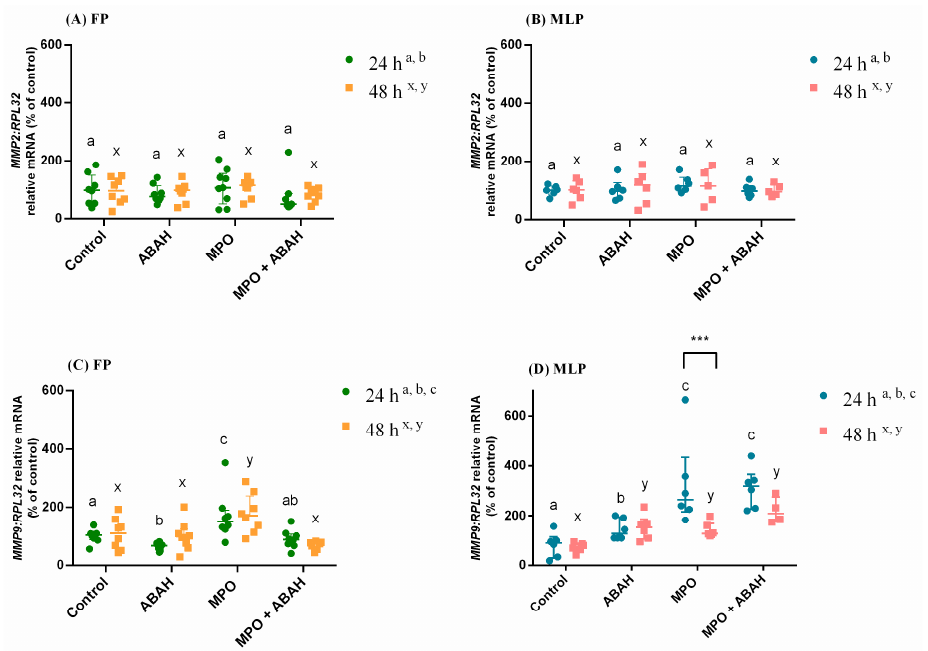
Figure 2. Transcription of MMP2 ( A , B ) and MMP9 ( C , D ) relative mRNA in mare endometrial explants from the follicular phase (FP) and the mid-luteal phase (MLP) treated with culture medium only (Control), myeloperoxidase (MPO: 0.5 µ g/mL), 4-aminobenzoic hydrazide (ABAH: 10 µ g/mL), or MPO (0.5 µ g/mL) + ABAH (10 µ g/mL) for 24 or 48 h. Results are presented as median with interquartile range. Significance was determined at p < 0.05. The differences among treatments with the same treatment time are signaled by distinct superscript letters (a,b,c—24 h; x,y—48 h). The differences among times of treatment for the identical treatment are depicted by asterisks (*** p <